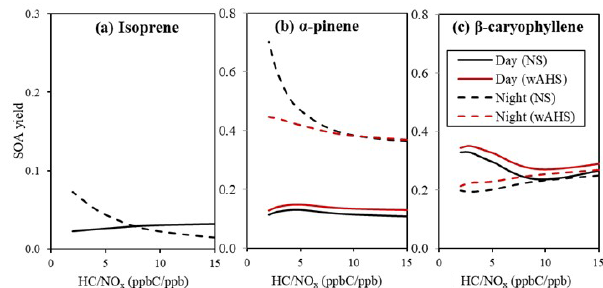
Figure 6. The biogenic SOA yield from (a) isoprene, (b) α -pinene, and (c) β -caryophyllene in both daytime (solid line) and nighttime (dashed line) under the various NO x levels. The RH and tempera- ture were set to 50% and 298K, respectively. The SOA formation was simulated with 10µgm − 3 of OM 0 with fixed initial concen- trations of isoprene, α -pinene, and β -caryophyllene of 50, 30, and 24ppb, respectively. The dry mass of wAHS is set to 20µgm − 3 . The daytime simulation is performed under the reference sunlight intensity (Fig. S1), which was measured on 19 June 2015 at the UF-APHOR. For the nighttime simulation, initial O 3 concentration was set to 30ppb. The wall-free model parameters were applied to simulate SOA formation (Han and Jang, 2022).